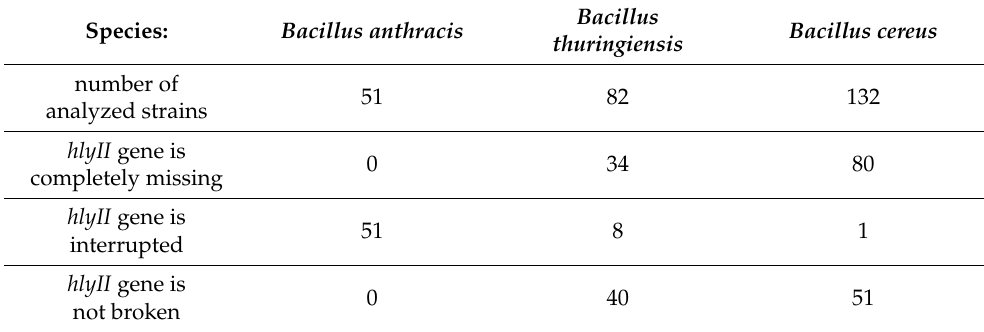
Bacillus cereus